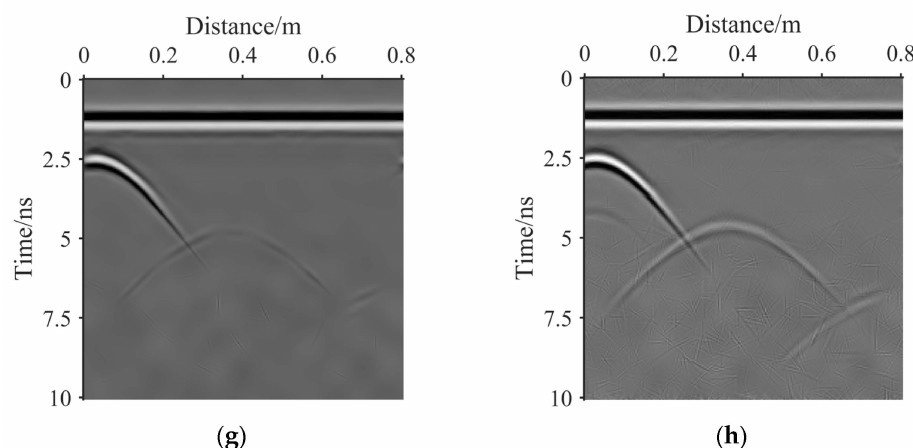
Figure 9. ( a ) The simulated noisy GPR image 2. ( b ) The result of bilateral filter. ( c ) The result of guided filter. ( d ) The result of NSST-1. ( e ) The result of NSST-2. ( f ) The result of NSST-3. ( g ) The result of NSST-4. ( h ) The result of the proposed